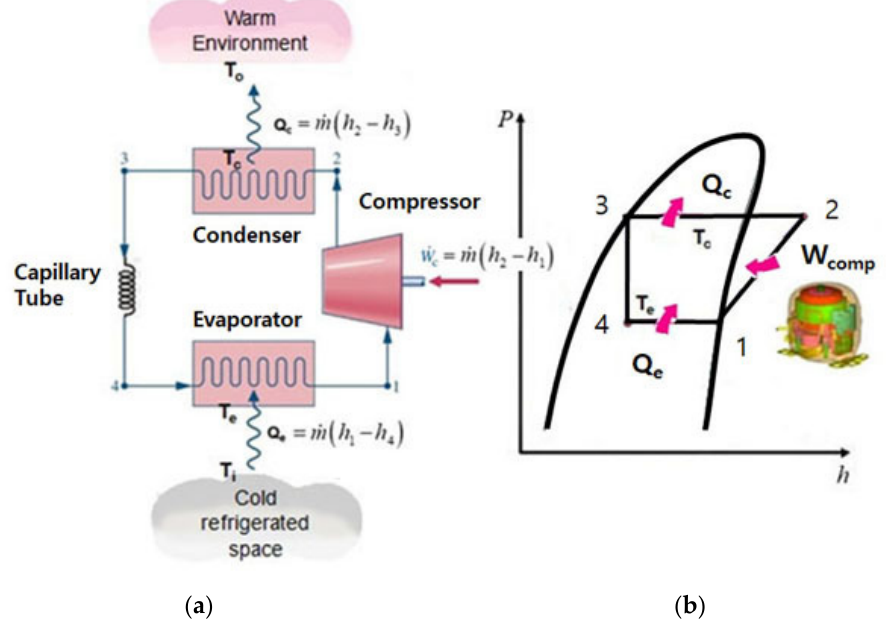
Figure 8. A domestic compressor in the refrigeration cycle: ( a ) vapor-compression refrigerator cycle, ( b ) P h diagram.